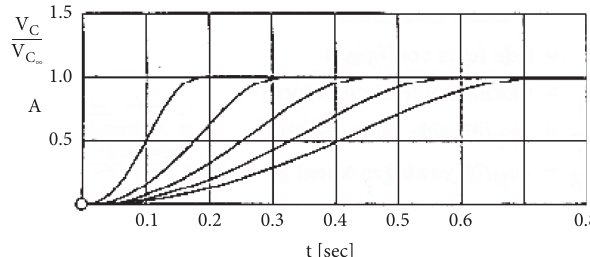
Figure 4: Lateral force coefficient and inverted torque due to strong wind [7].